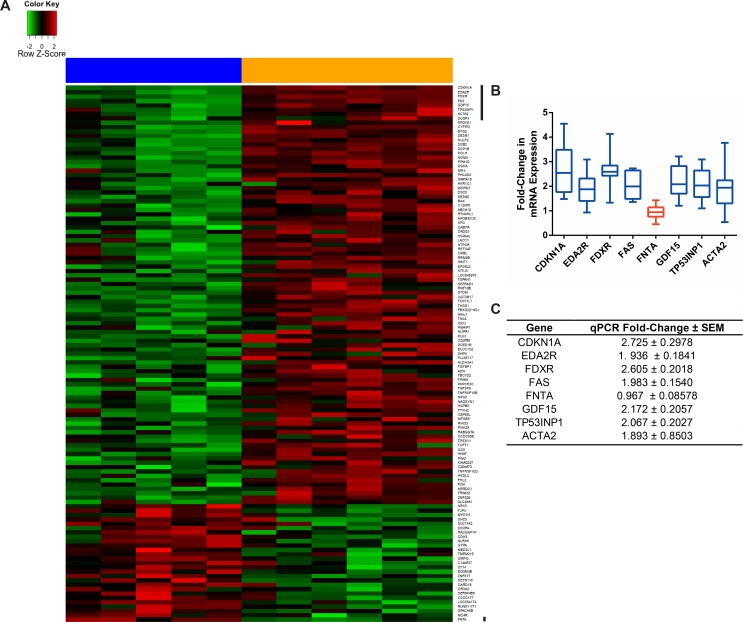
Differentially expressed genes in A549 cells following cisplatin treatment at its IC10.The heat map represents the gene expression profile for the differentially expressed genes identified between untreated (blue) and cisplatin-treated (orange) cells (A). Each column displays data from one microarray chip. Genes that were further validated by qPCR are highlighted with a black vertical line beside the gene. The fold-changes in mRNA expression are plotted in the box plot (B; blue = over-expression, red = under-expression after cisplatin treatment) and the averaged values are tabulated from six individual experiments at each time-point (C). All changes observed were statistically significant (p<0.05) except for FNTA.